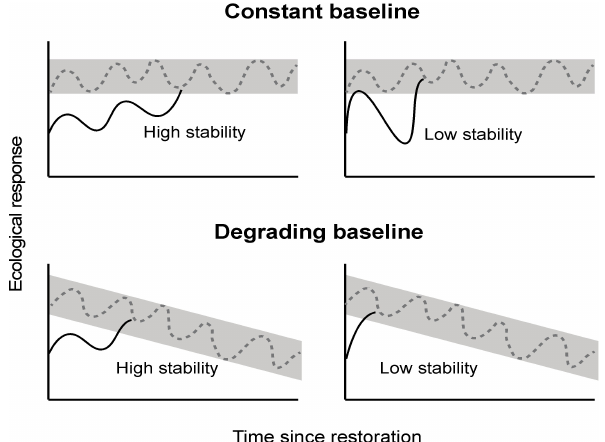
Fig. 2 . The influence of baseline conditions on apparent rates of recovery in damaged ecosystems. The figure shows situations where baseline conditions (+/- SD) are consistent (upper panel) and degrading (lower panel) over time. Solid black lines indicate the ecological trajectory of restored sites and end where there is no statistical difference between restored and baseline conditions. Perceived recovery occurs much more rapidly under low stability or because of degrading baseline